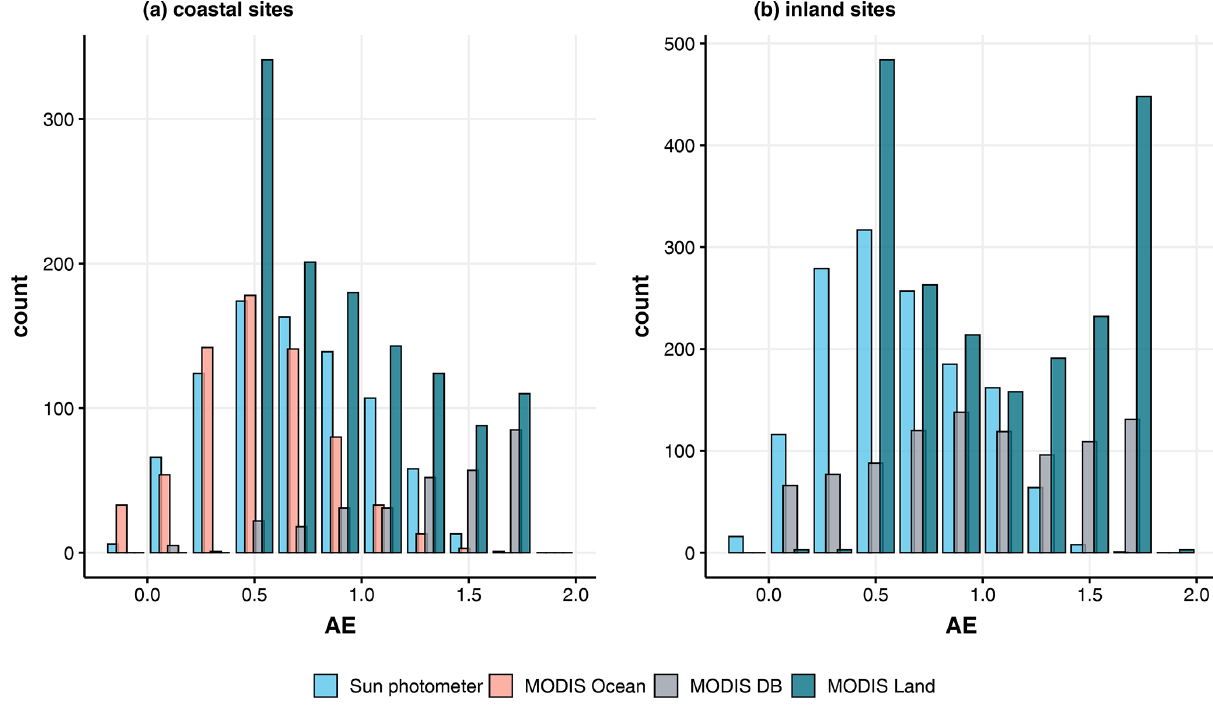
Figure 6. Comparative histograms of Ångström exponents for coincident sun photometer, MODIS Deep Blue, and MODIS Land and Ocean algorithms for (a) coastal sites and (b) inland